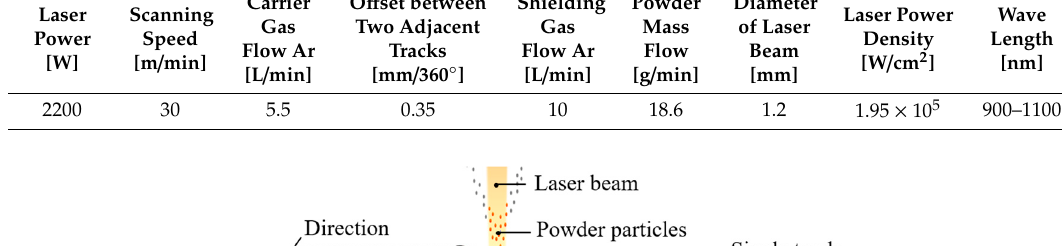
Figure 2. Picture of the EHLA process (coating of a rod) and scheme of the EHLA process. Table 1. Process parameters used for the manufacturing of layers using EHLA.